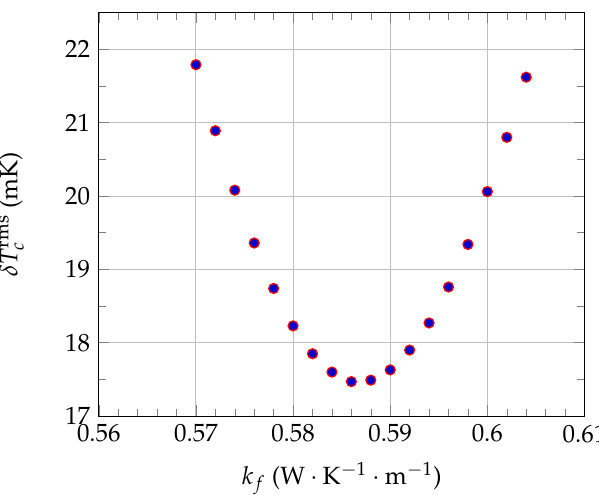
Figure 19. Principle of the determination of pure water thermal conductivity k mea electro-thermal systemic modeling (ESM) approach. The values of pure water density ρ f and specific heat c f at T 0 = 24.0 ◦ C used in the systemic modeling are given in Table